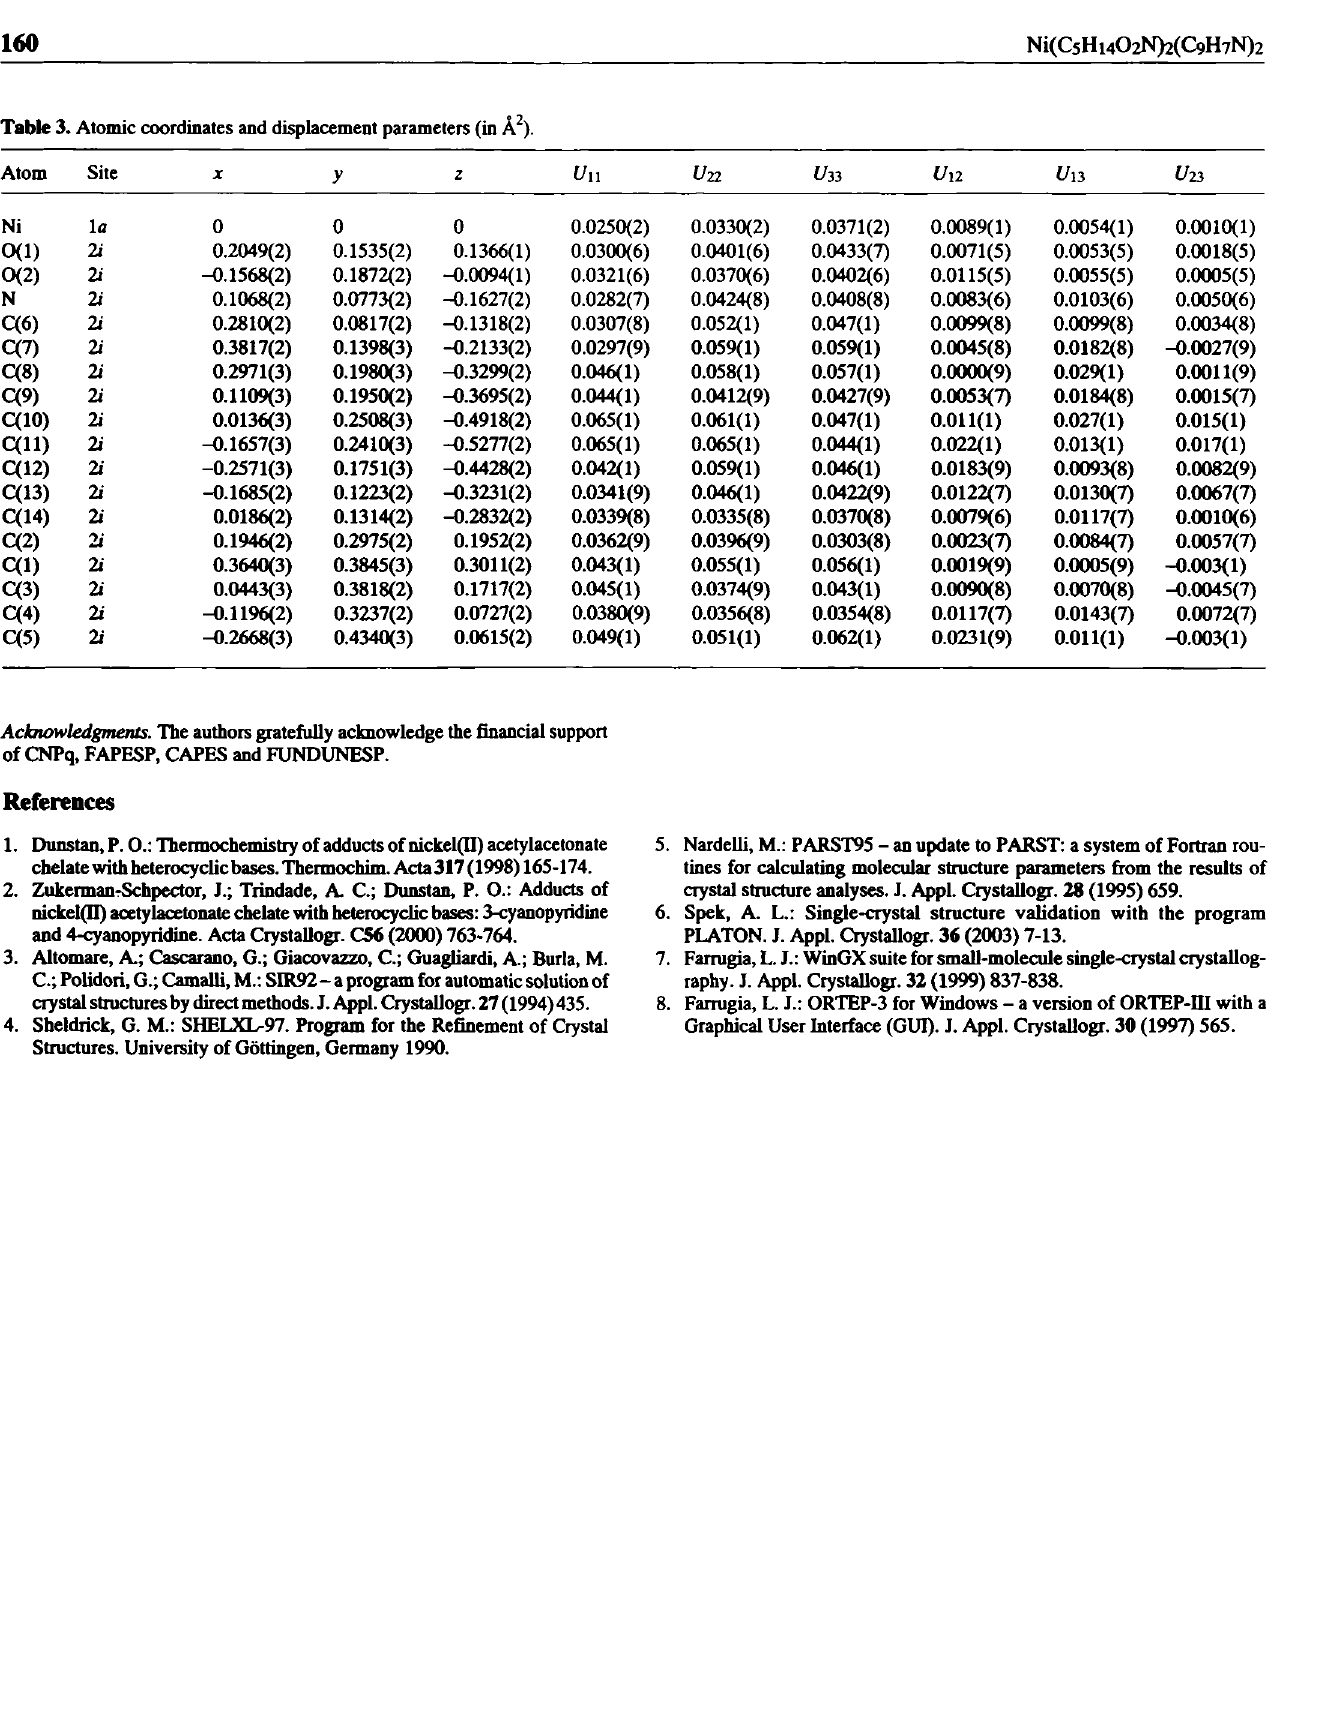
Table 3. Atomic coordinates and displacement parameters (in A 2